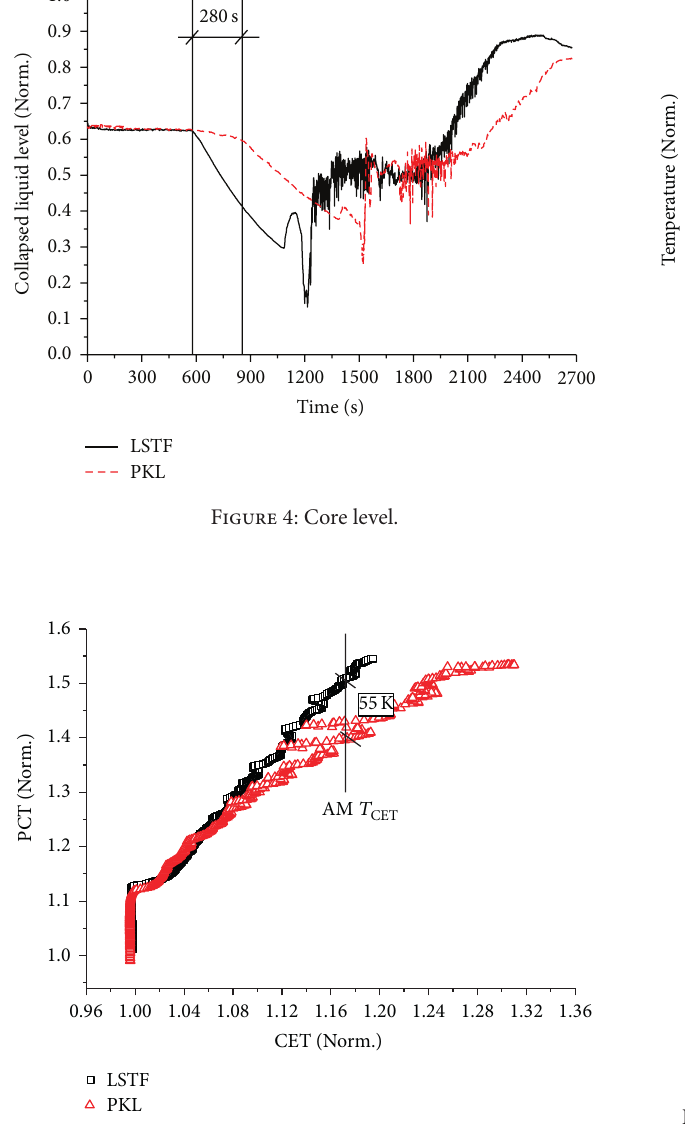
Figure 5: CET versus PCT curve.